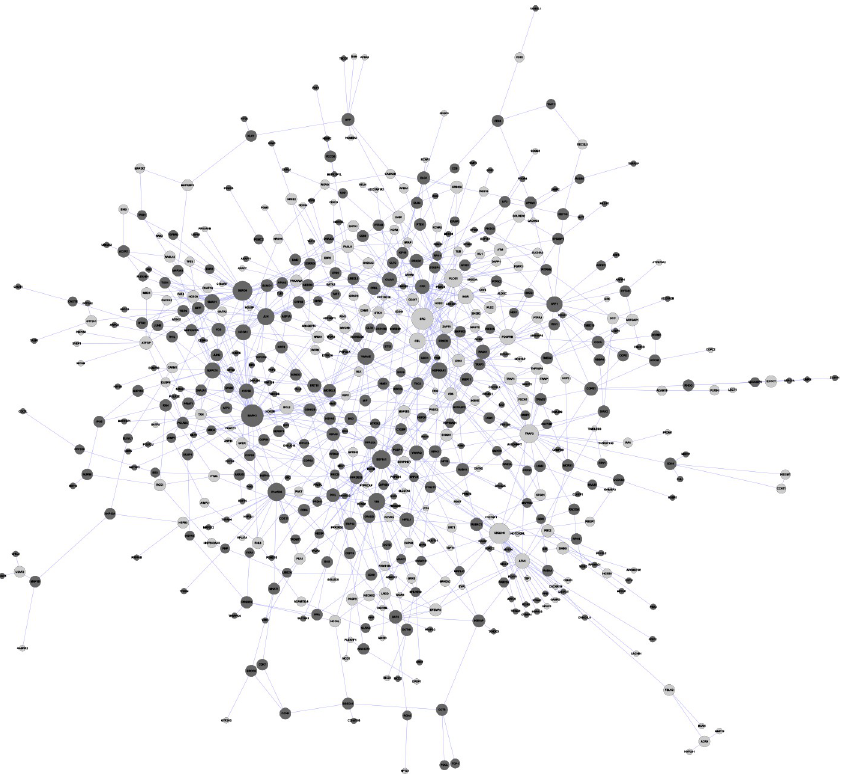
Fig 3. PPI network.